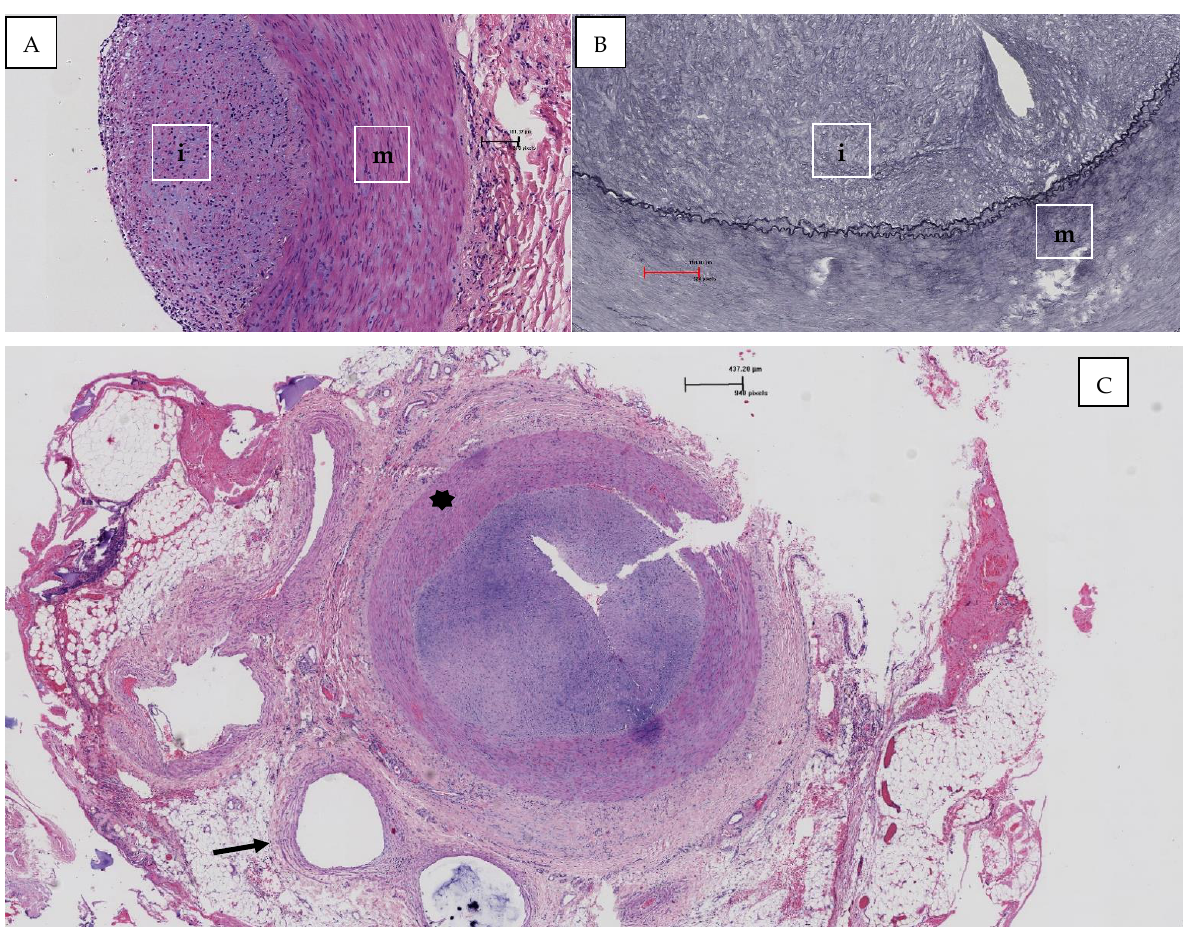
Figure 3. ( A ): The microscopic image of the radial artery shows thickening of the intima due to the deposition of myxoid matrix (Hematoxylin and Eosin, magnification 100×, i: intima, m: tunica media); ( B ): the staining for the elastic fibers shows duplication of the elastic lamina (Weighert, magnification 100×, i: intima, m: tunica media, arrow: elastic lamina); ( C ): the image shows the vessel affected by intimal fibroplasia with a marked reduction of the lumen (star) in comparison with an adjacent artery (arrow) (Hematoxylin and Eosin, magnification 20×).